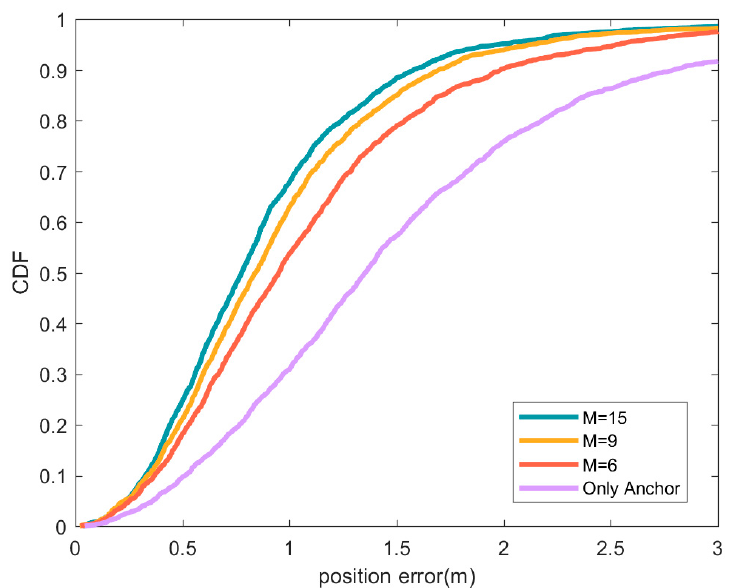
Figure 9. CDF of position error under different number of preferred positioning sources. In the figure, the green line represents the location error CDF when the preferred location source is 15, the orange line represents the preferred location source is 9, and the red line represents the preferred location source is 6. The purple line indicates the situation where only anchor nodes are used for positioning.